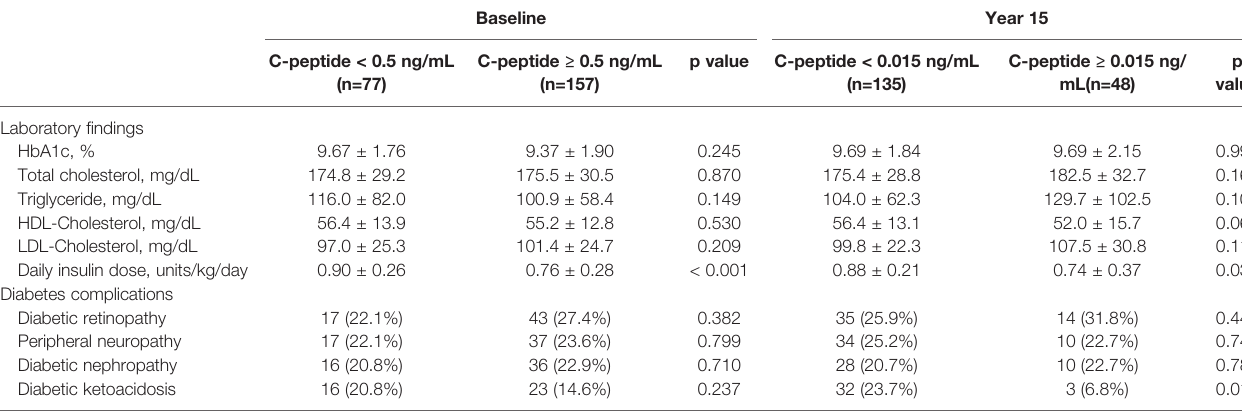
TABLE 3 | Comparison between two groups divided by serum C-peptide level at diagnosis and 15 years after